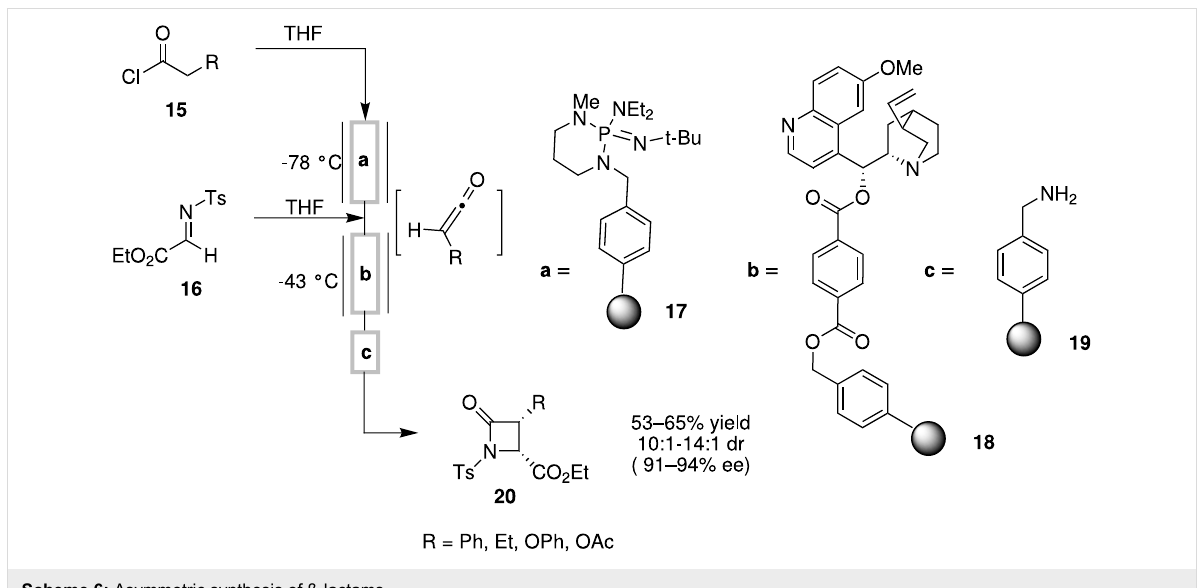
Scheme 6: Asymmetric synthesis of